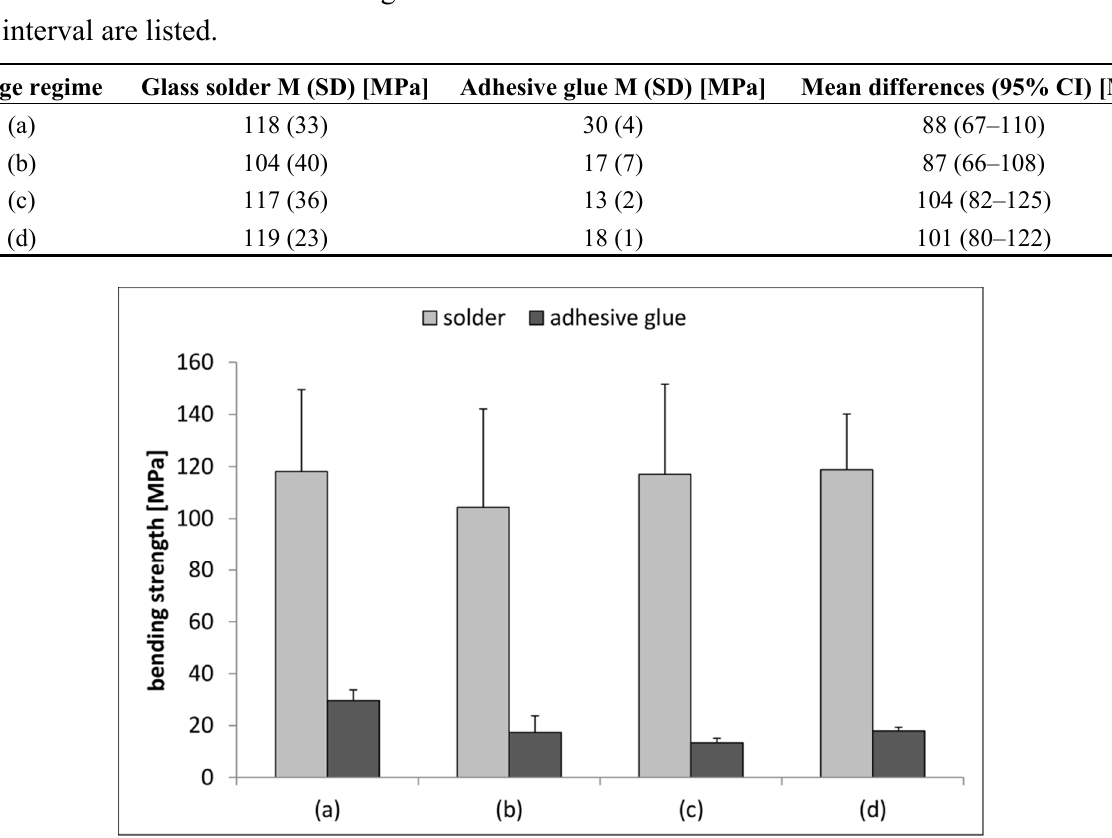
Figure 4. Bending strength values for soldered and glued compound samples in native condition ( a ); after 30 or 90 days in humid condition (( b ) and ( c ), respectively); and after artificial aging ( d